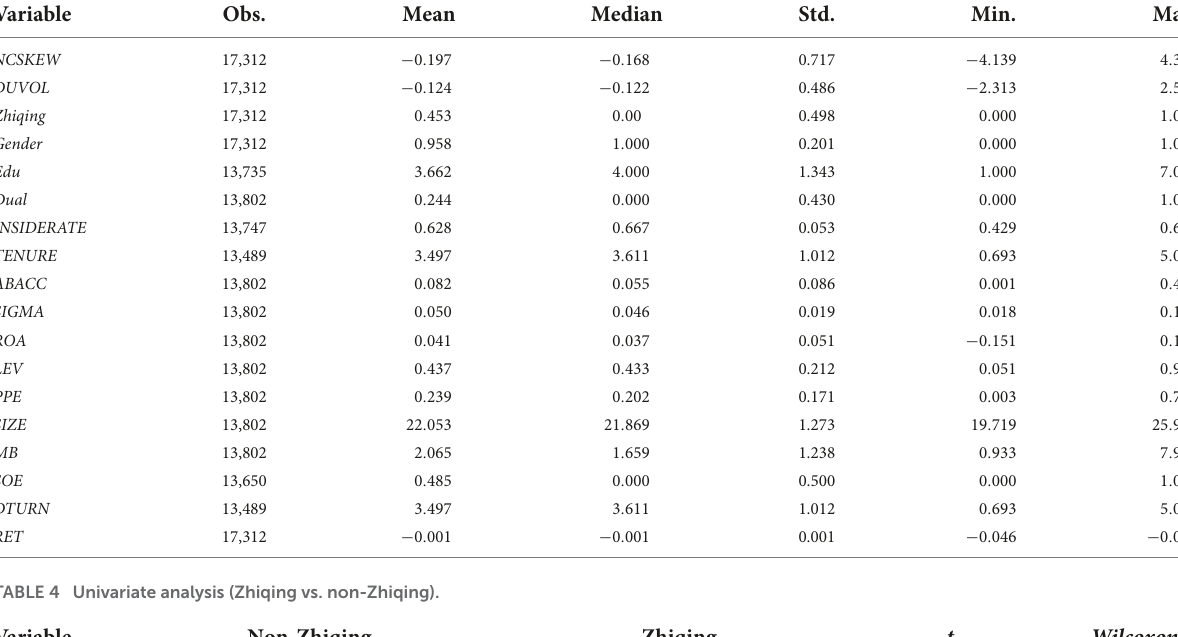
TABLE 3 Descriptive statistics of variables.